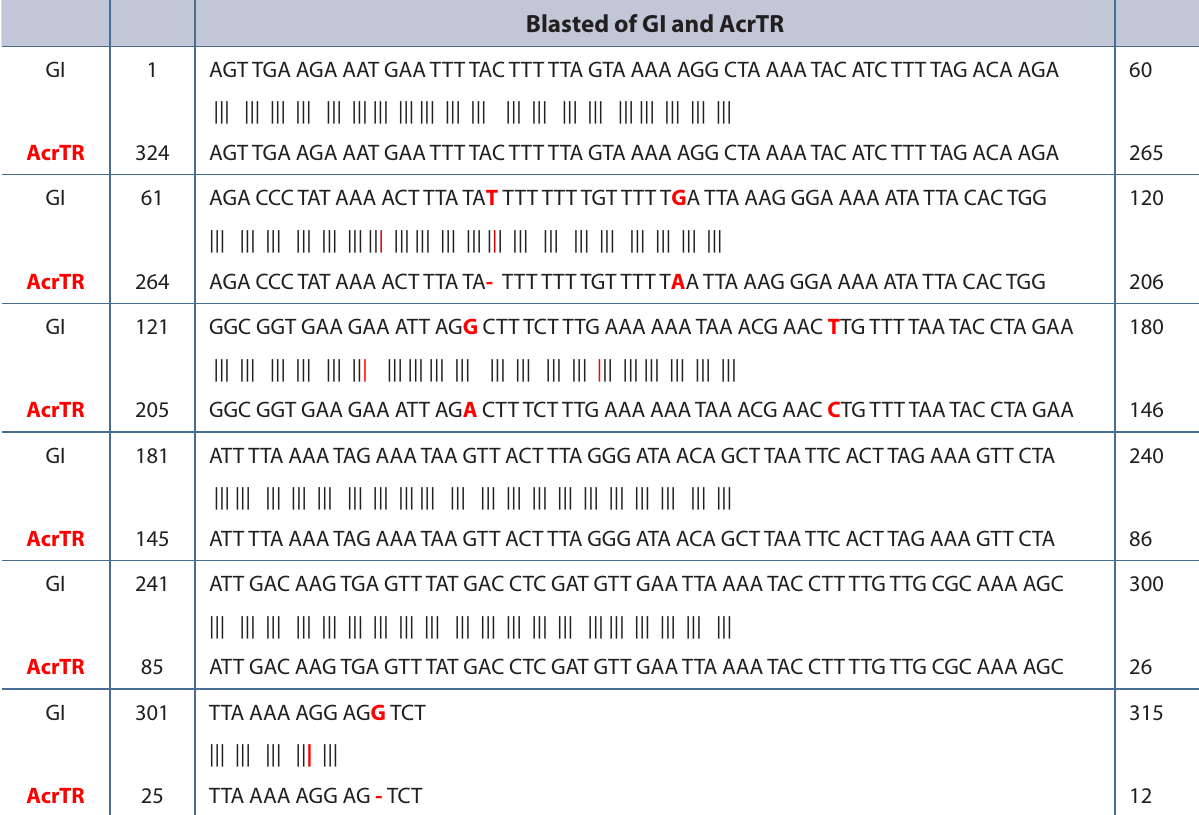
Table 3. BLAST result between genetic group I (GI) DNA sequences and AcrTR (accession number AJ277598) Blasted of GI and AcrTR